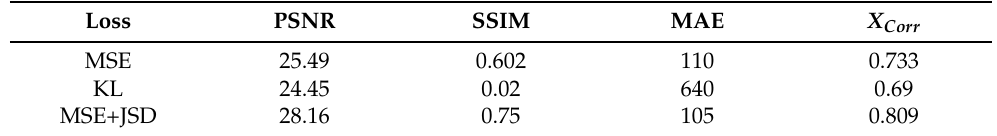
Table 3. The evaluation metrics of different loss functions on ADNI for the proposed method after 1000